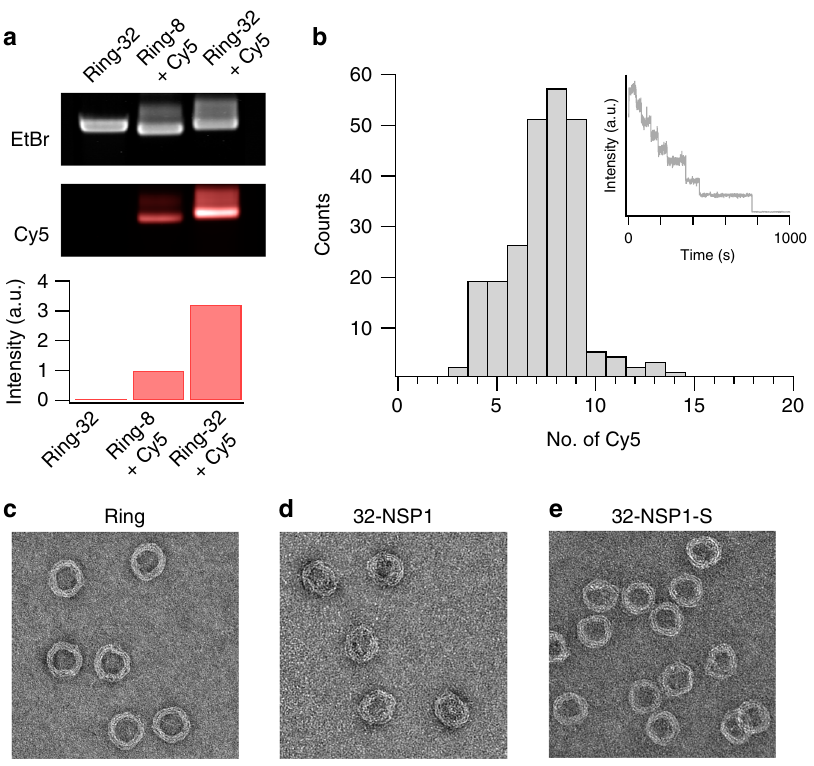
Fig. 2 Attachment of NSP1 and NSP1-S to the DNA ring. Top: laser-scanned EtBr images of ( a ) 1% agarose gel on which DNA origami ring samples were electrophoresed. Middle: same gel scanned in Cy5 excitation/emission channels. Cy5-labeled DNA strands were added to FG-Nup attachments where indicated. Bottom: integrated Cy5 band intensity normalized to EtBr intensity. b Histogram of the number of attached Cy5-labeled oligomers for an 8- attachment ring. Inset shows an exemplary intensity trace of a single-particle recording of a DNA ring with 8 attachment sites incubated with the complementary Cy5-labeled oligonucleotide obtained using total internal re fl ection microscopy (TIRF) (Methods section and Supplementary Figure 4). See Supplementary Figure 5 for additional intensity traces. c – e Exemplary fi eld-of-view negative staining TEM micrographs of DNA origami NCP-mimic ring without protein, with 32-NSP1, and 32-NSP1-S, respectively. See Supplementary Figure 6 for exemplary particles. Scale bar = 50